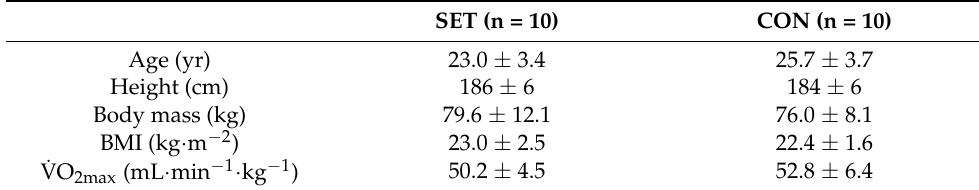
Table 1. The study was approved by the National Committee on Health Research Ethics (H-17004045) and conducted in accordance with the Declaration of Helsinki (2013). The study was registered at clinicaltrials.gov (NCT03317704). Table 1. Subject characteristics at